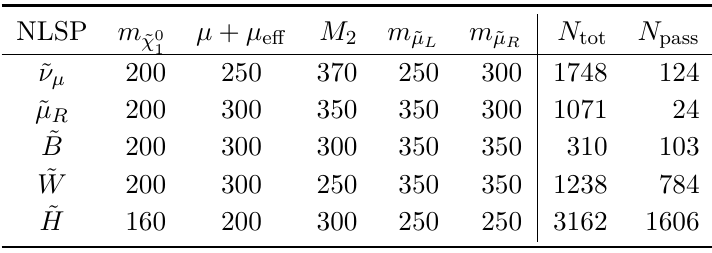
Table 1 . Summarization of the samples classified by their NLSP’s dominant component. N tot represents the total number of each type of samples surveyed by specific Monte Carlo simulations. N pass represents the corresponding number satisfying R < 1 . The lower limits of parameters ( µ + µ ) , M , m , m , and m for the samples surviving the constraints are given in units of eff 2 ˜ µ L ˜ µ R ˜ χ 0 1 GeV in each